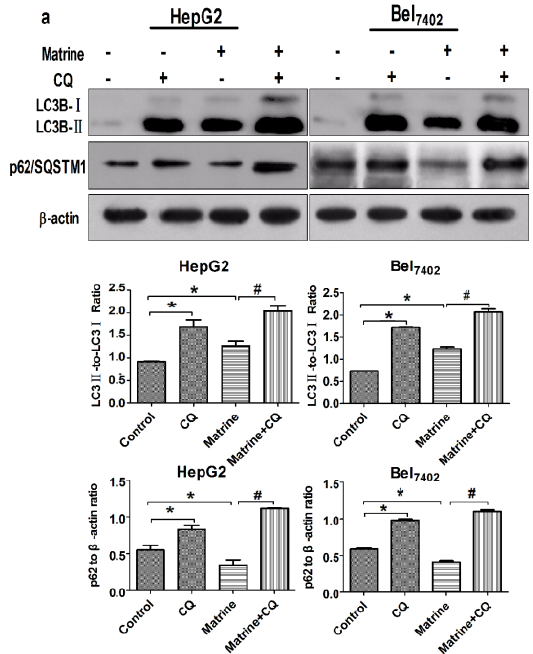
Figure 3. CQ inhibited matrine-induced autophagic flux in HepG2 and Bel cells were treated with 0.8 mg/mL matrine in the absence or presence of HepG2 and Bel 7402 CQ (7.8 µM) for 48 h. ( a ) Western blot analysis of expression of the LC3BII/LC3BI ratio and p62/SQSTM1. β -actin is shown as a loading control; ( b ) Representative confocal images after transfection with GFP-LC3 and staining with LysoTracker Red. The